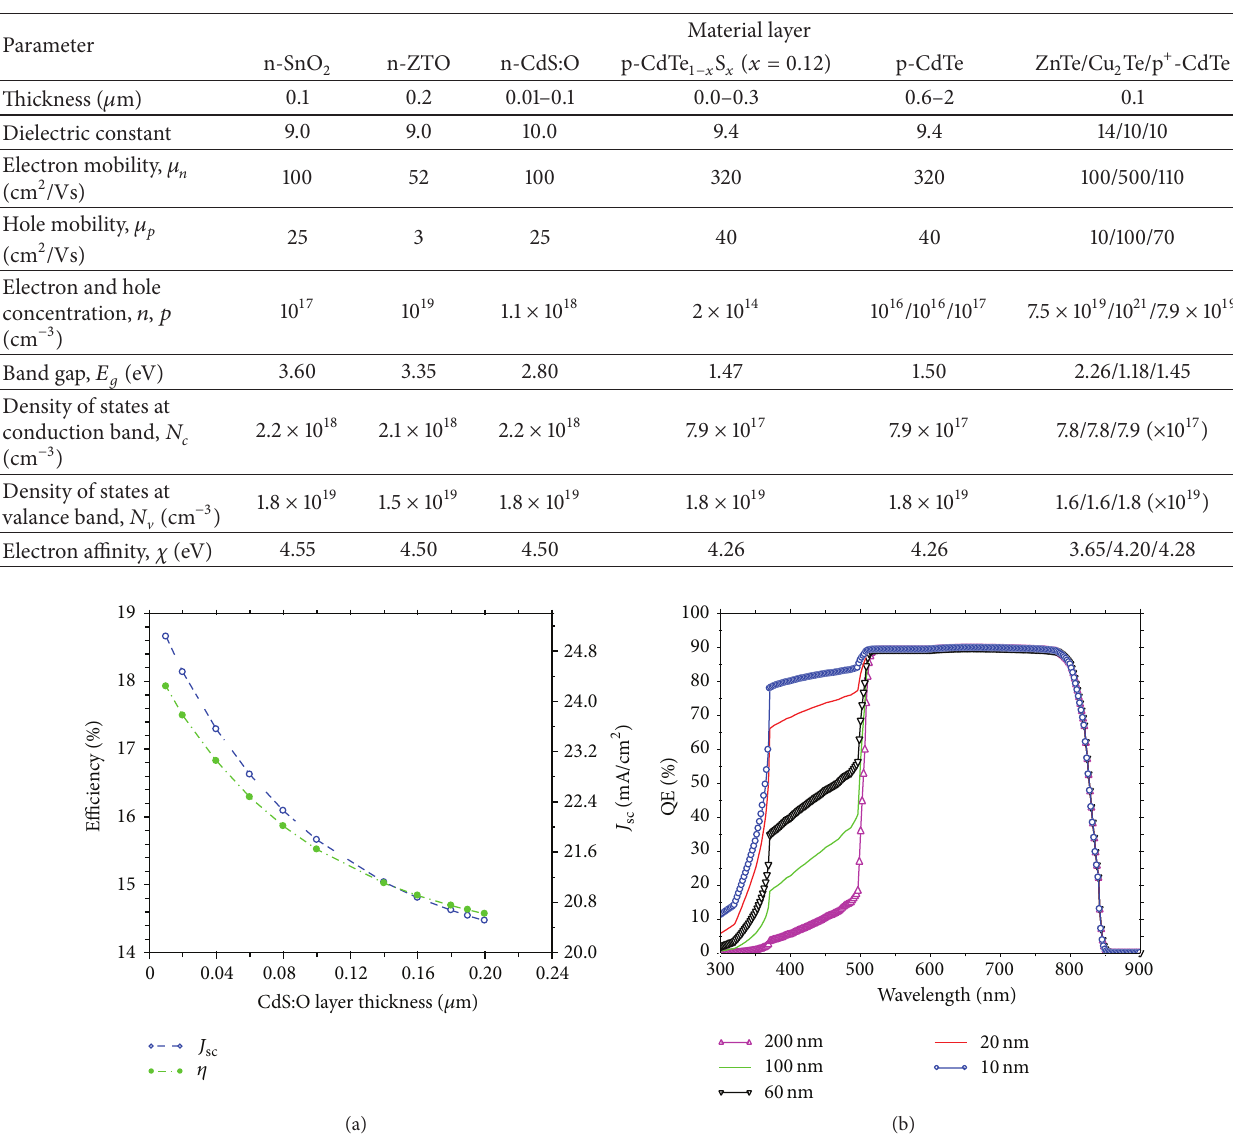
Table 2: Material parameters used in the numerical analysis for the nano-CdS:O/CdTe cell.